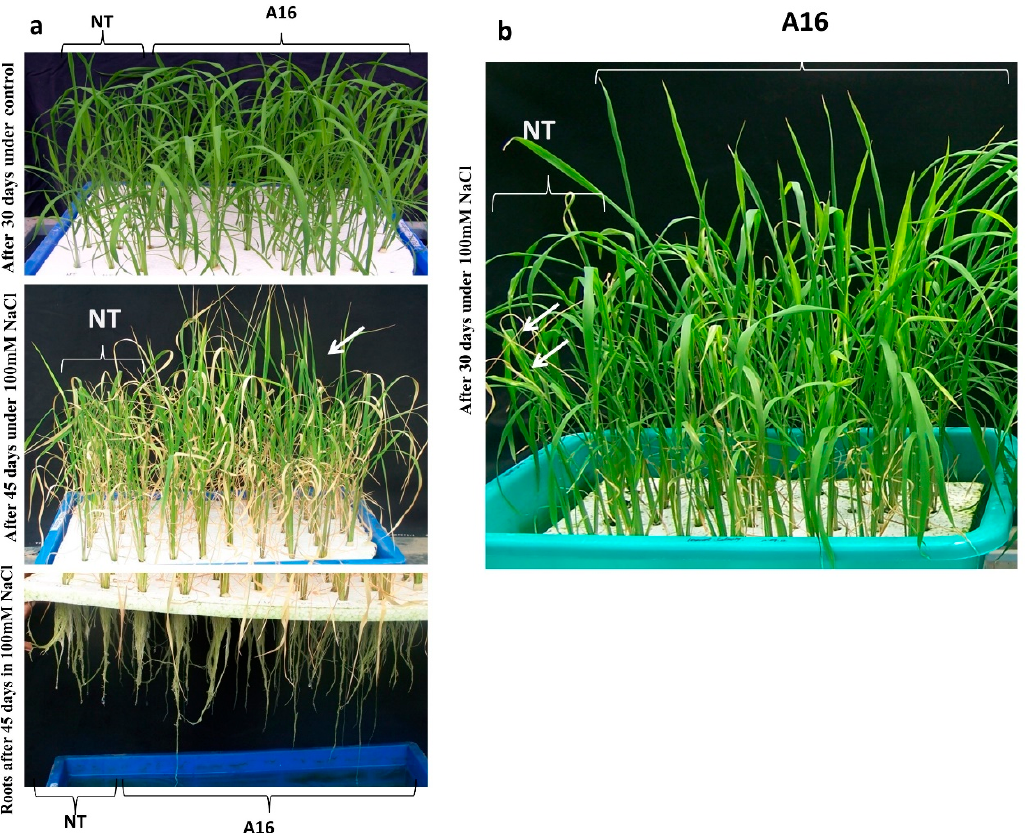
Figure 9. Responses of non-transgenic and transgenic ADT 43 (# A16) seedlings to 100 mM NaCl stress; ( a ) Morphology of leaves and roots of transgenic (T 2 ) and non-transgenic ADT 43. White arrow indicates the erect leaves of A16 transgenic line; ( b ) Responses of transgenic (T 3 progenies of # A16) at 30 DAIS. The white arrow indicates the leaf rolling and chlorosis symptoms in non-transgenic plants.